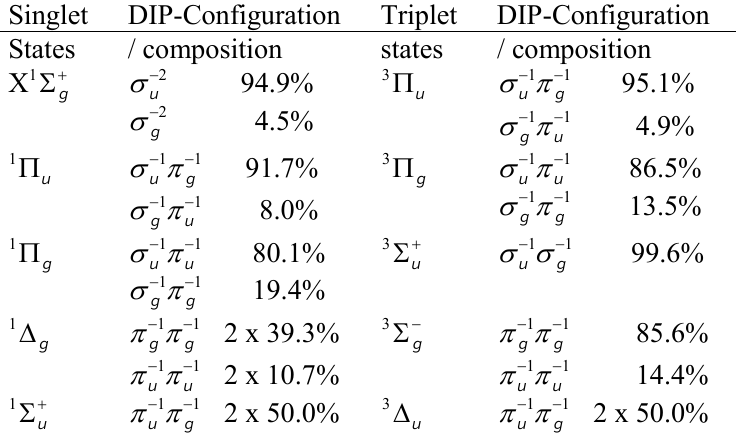
molecule at R=141.36 pm, 2